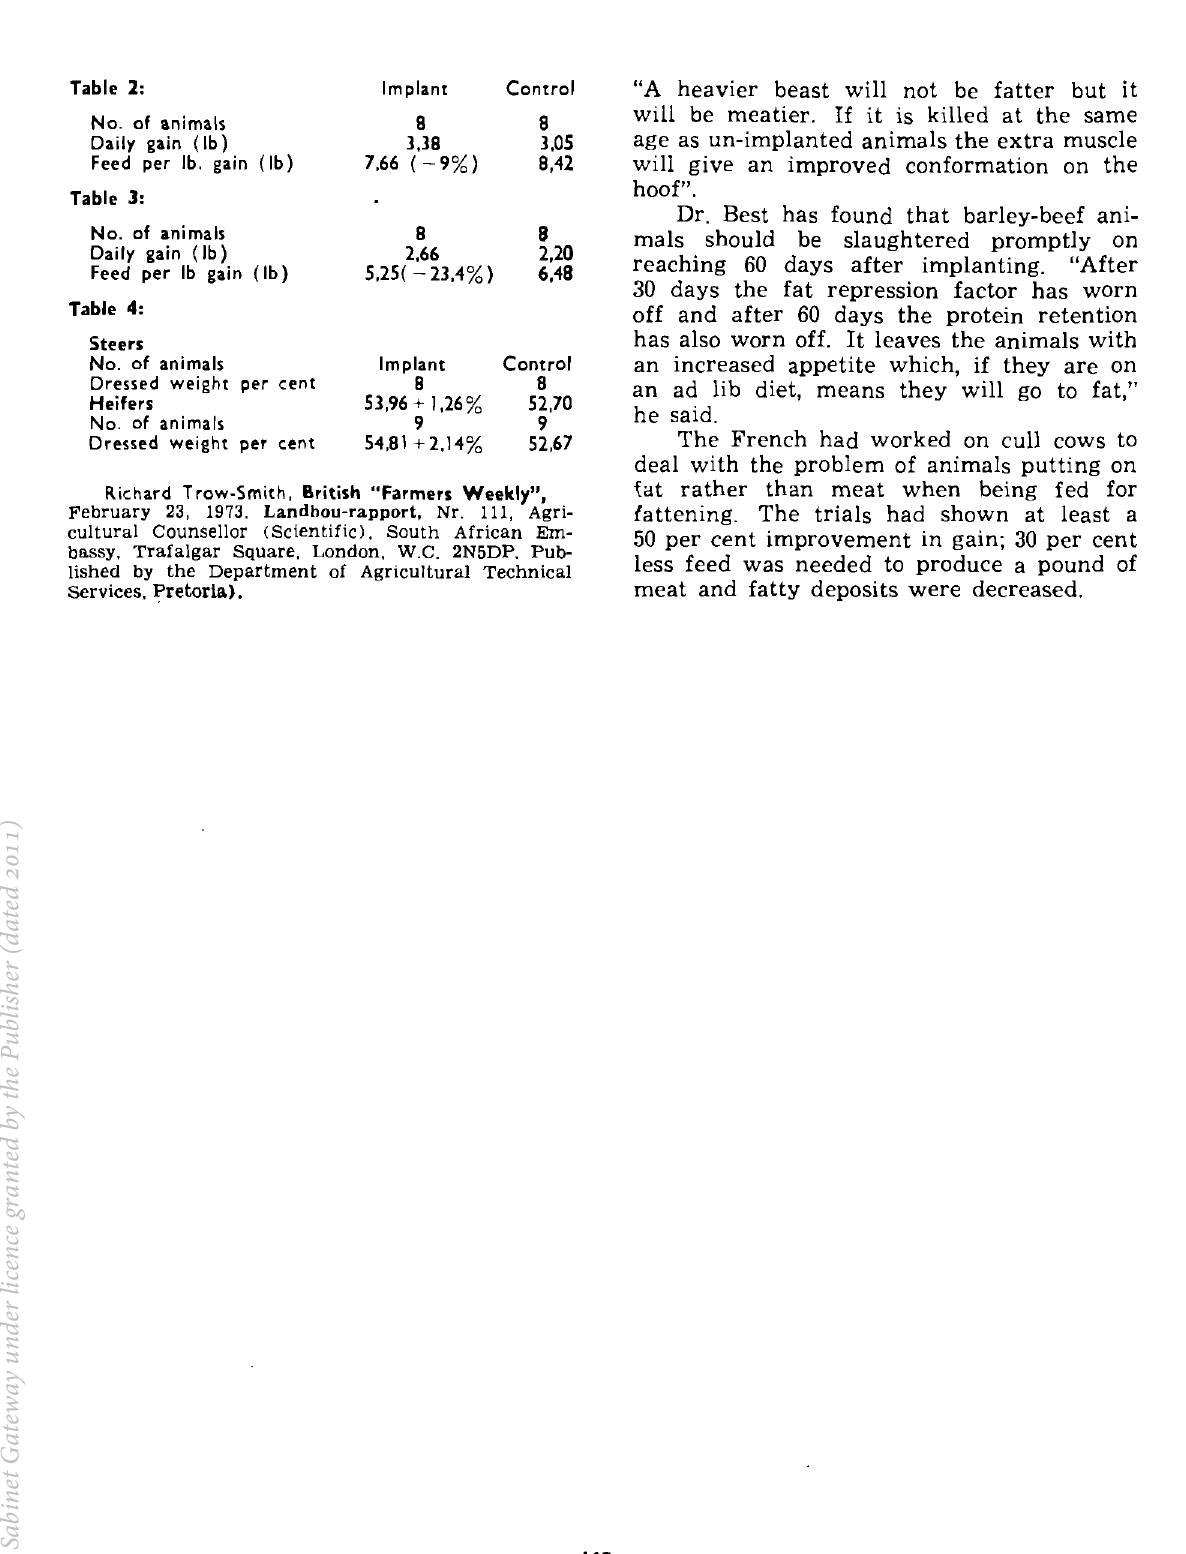
Implant Control